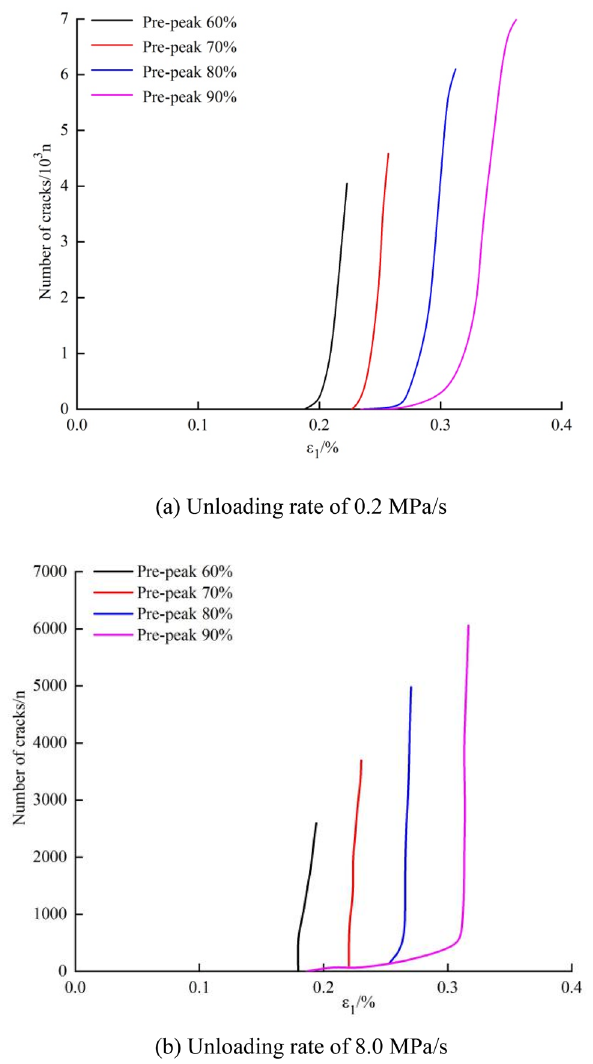
Figure 10. Crack number-strain curves of the marble during failure at different initial unloading stresses of the confining pressure.